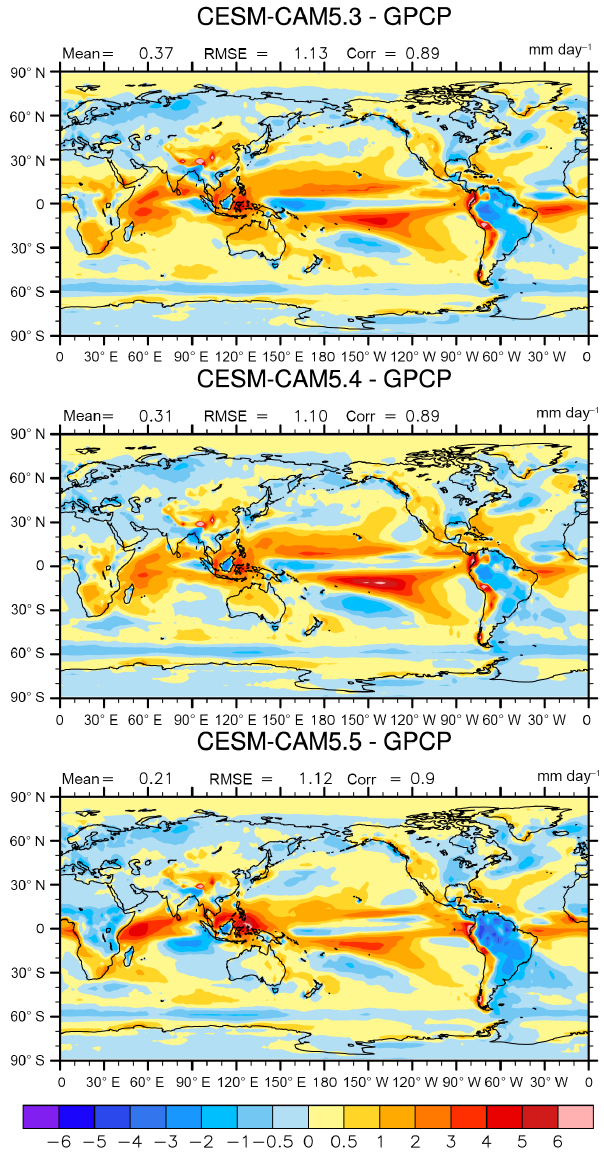
Figure 4. Same as Fig. 2 but for longwave cloud forcing biases. Figure 5. Same as Fig. 2 but for precipitation biases computed rel- ative to GPCP